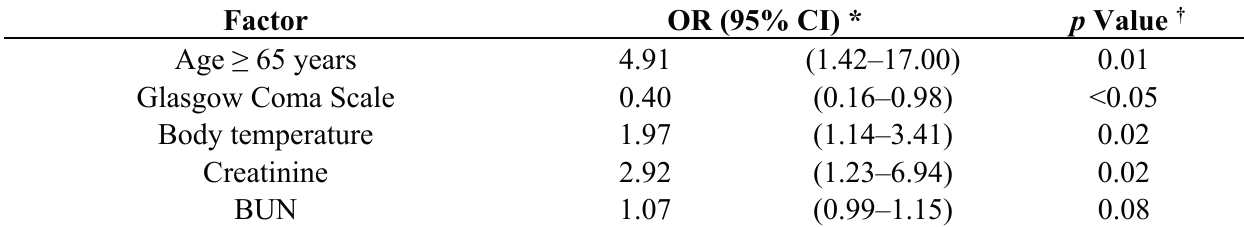
Table 2. Independently associated factors for the hospitalization of patients with heat